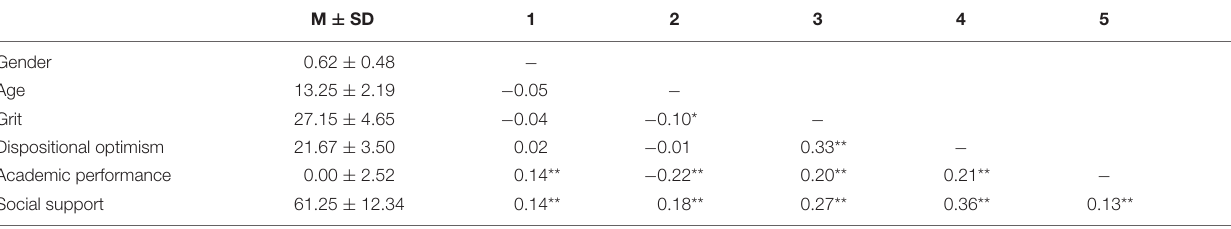
TABLE 1 | Descriptive statistics and correlation matrix for each variable ( n = 513).